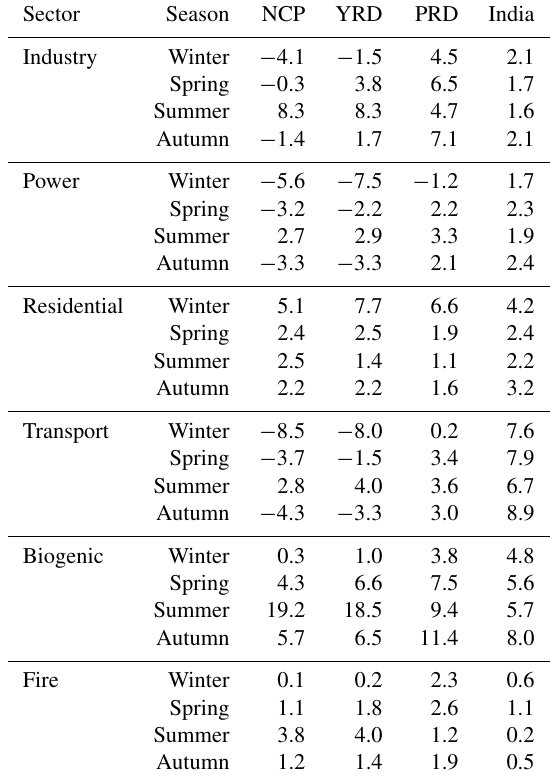
Table 3. Sensitivity of seasonal O 3 to emission sectors for different regions (ppb).